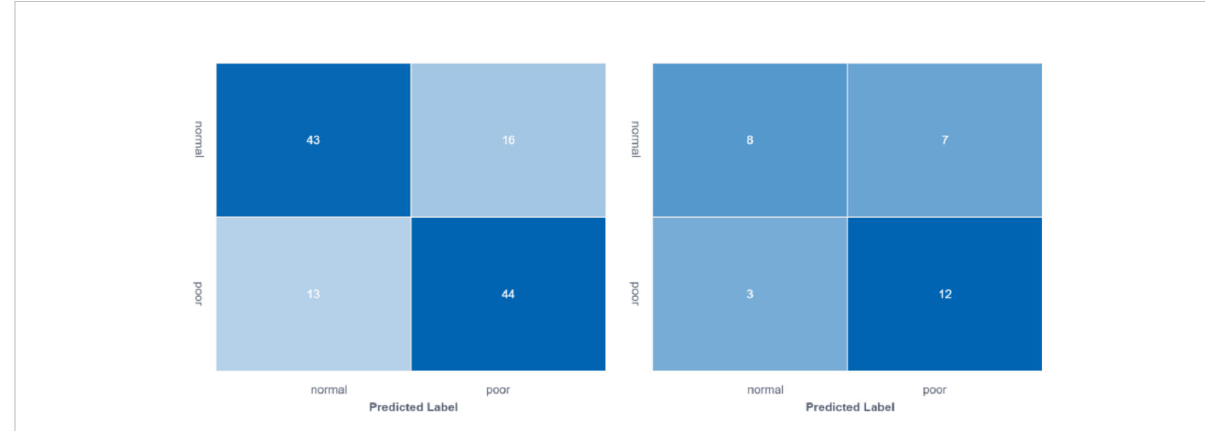
FIGURE 3 Comparison of feature model cross-validation performance between training group and validation group.